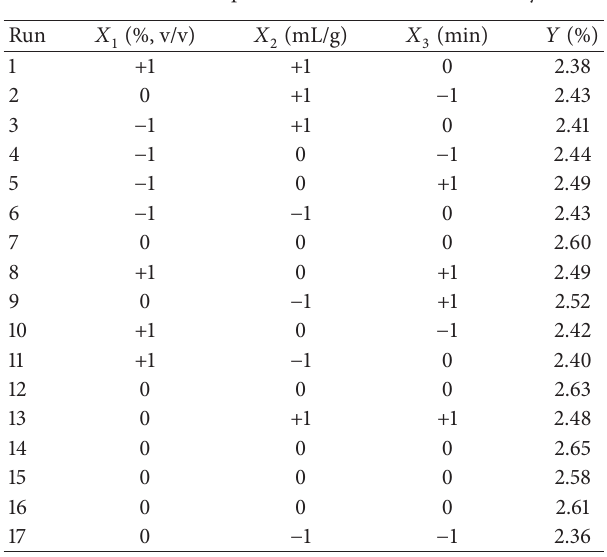
Table 2: BBD for independent variables and extraction